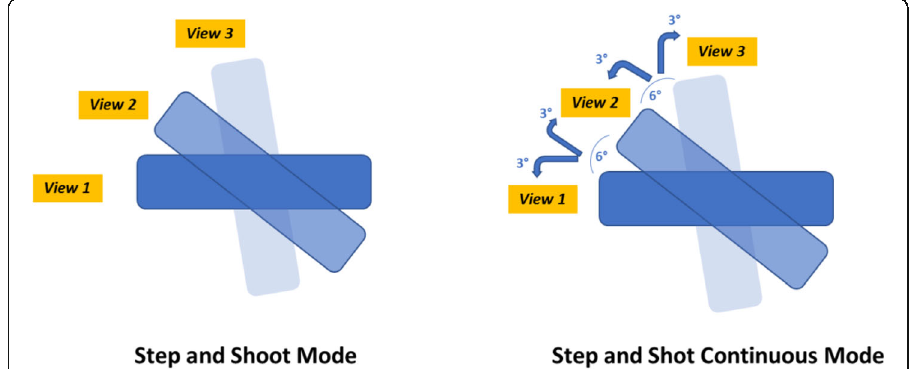
Fig. 1 An illustration of step-and-shoot (SS) versus step-and-shoot continuous (SSC) mode acquisition, demonstrating incorporation of counts during the detector head rotation in SSC